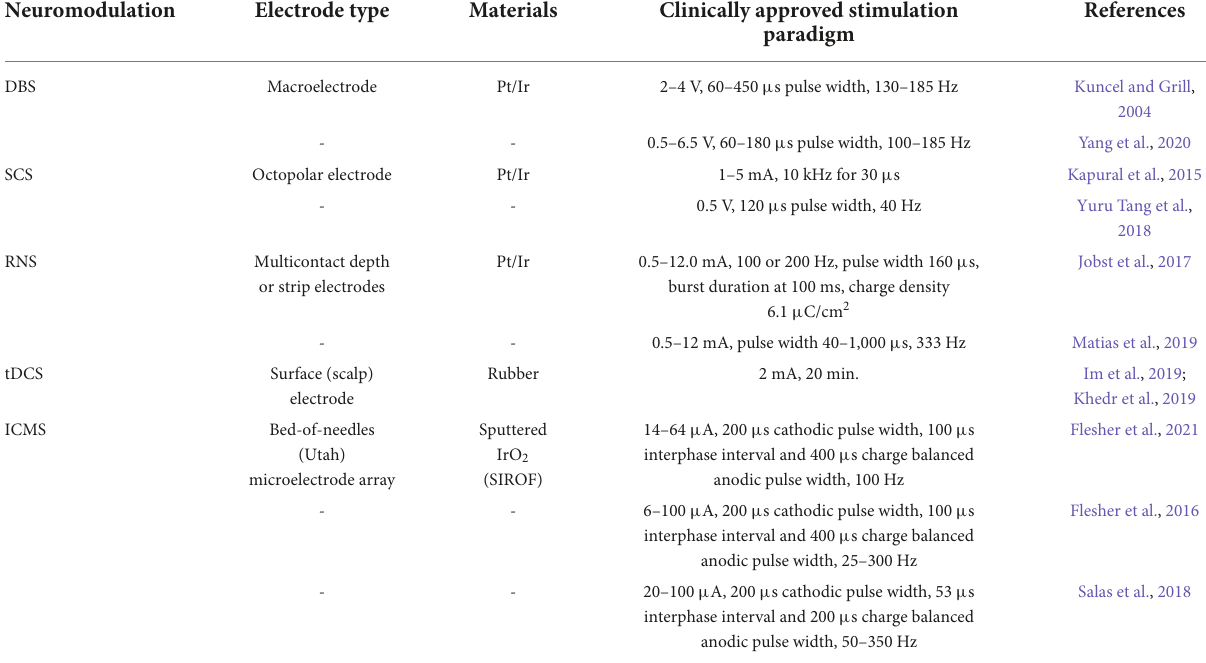
TABLE 1 Summary of stimulation parameters reported in literature for the major stimulation modalities discussed in this